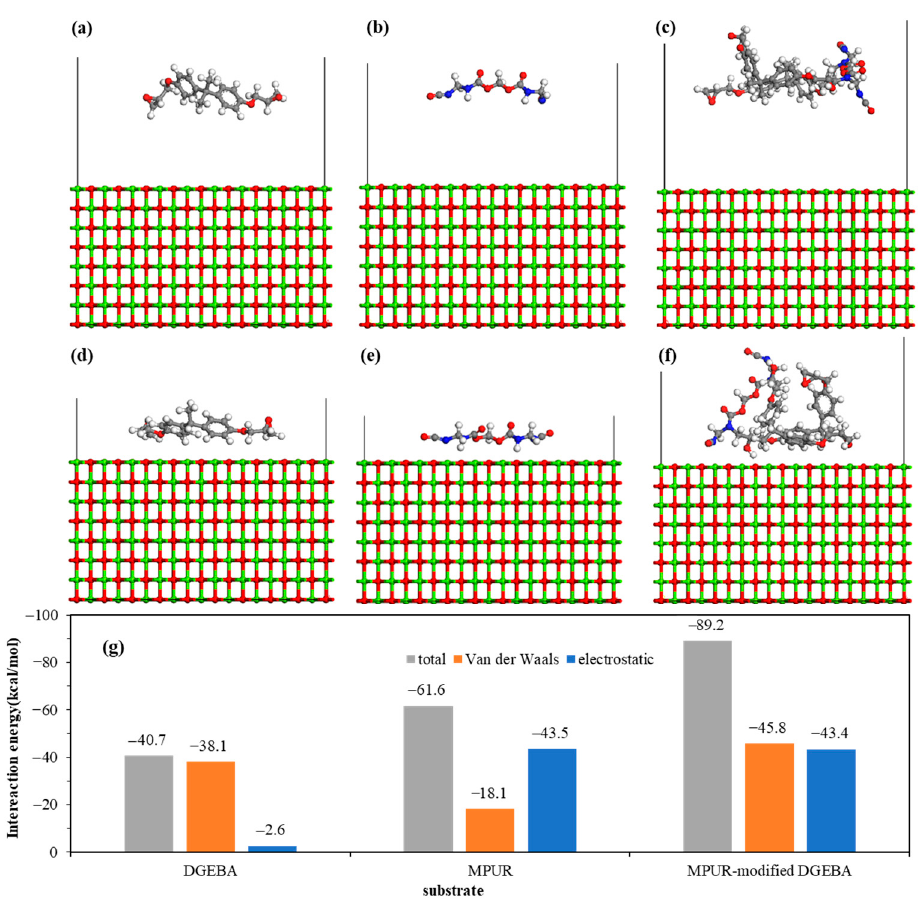
Figure 8. Molecular structure of MgO(100) surface before and after interaction with ( a , b ) DGEBA, ( c , d ) MPUR, and ( e , f ) MPUR-modi fi ed DGEBA, and ( g ) their adsorption energy. ( c , d ) MPUR, and ( e , f ) MPUR-modified DGEBA, and ( g ) their adsorption